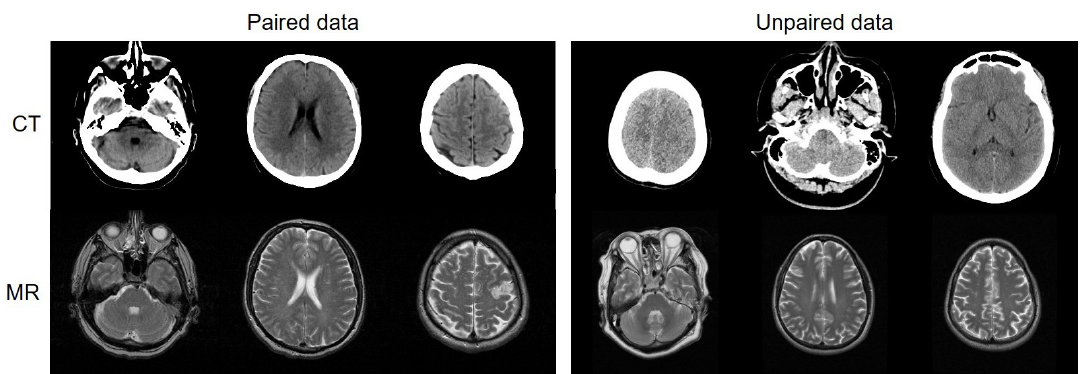
Figure 1. ( Left ): Deep networks train with paired data, which include CT and MR slices taken from the same patient at the same anatomical location. Paired data must be intentionally collected and aligned, which imposes difficulty. However, paired data provide network regression constraints that are far more correct. ( Right ): Deep networks train with unpaired data, which include CT and MR slices taken from different patients at different anatomical locations. There is a considerable amount of unpaired data